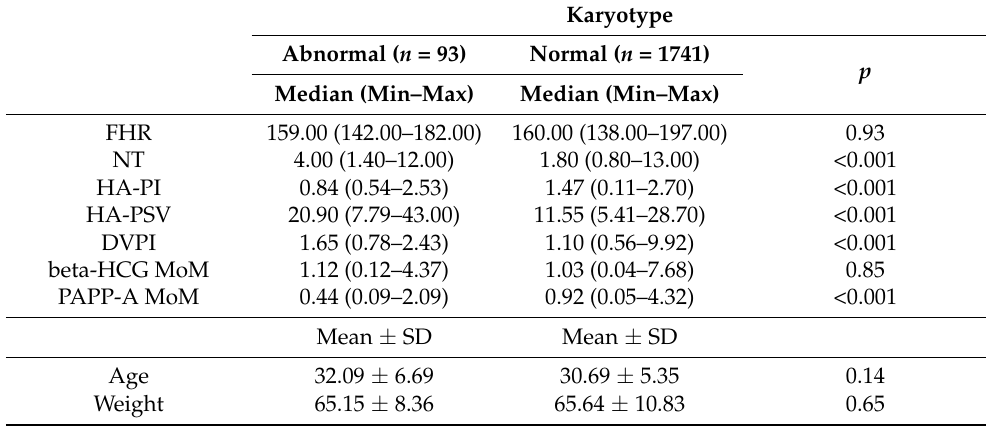
Table 2. Differences between selected first-trimester screening parameters depending on the karyotype.